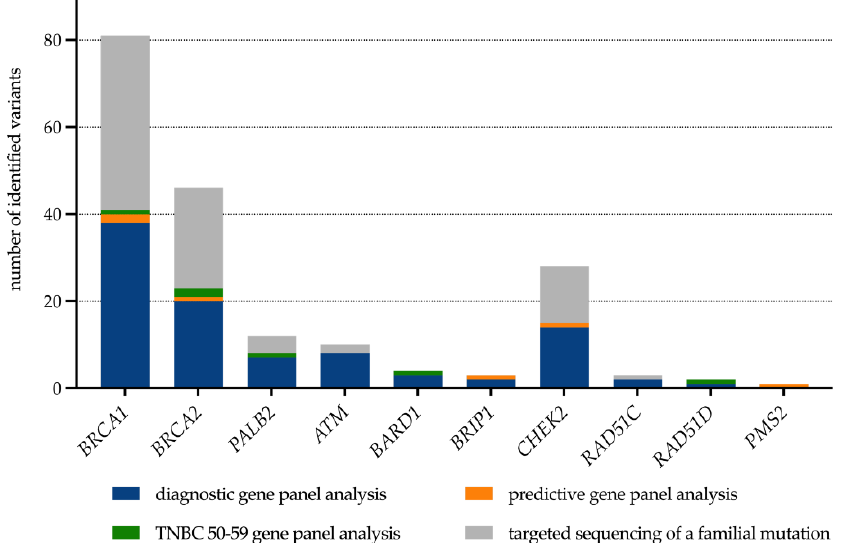
Figure 5. Spectrum of pathogenic or likely pathogenic variants identified in the establishing phase of the Familial Breast and Ovarian Cancer Center Greifswald. Of note, three patients carry mutations in two HBOC-associated risk genes.